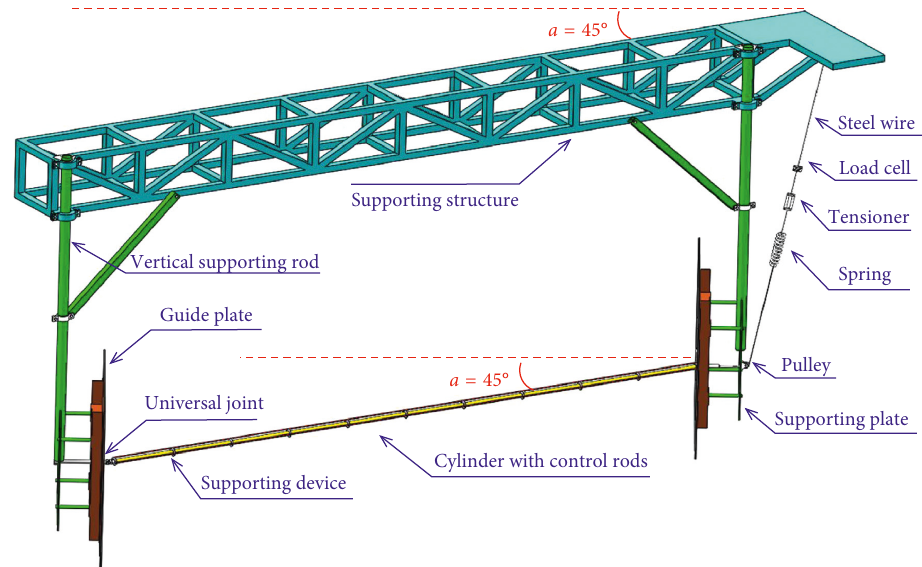
Figure 3: Sketch of the experimental